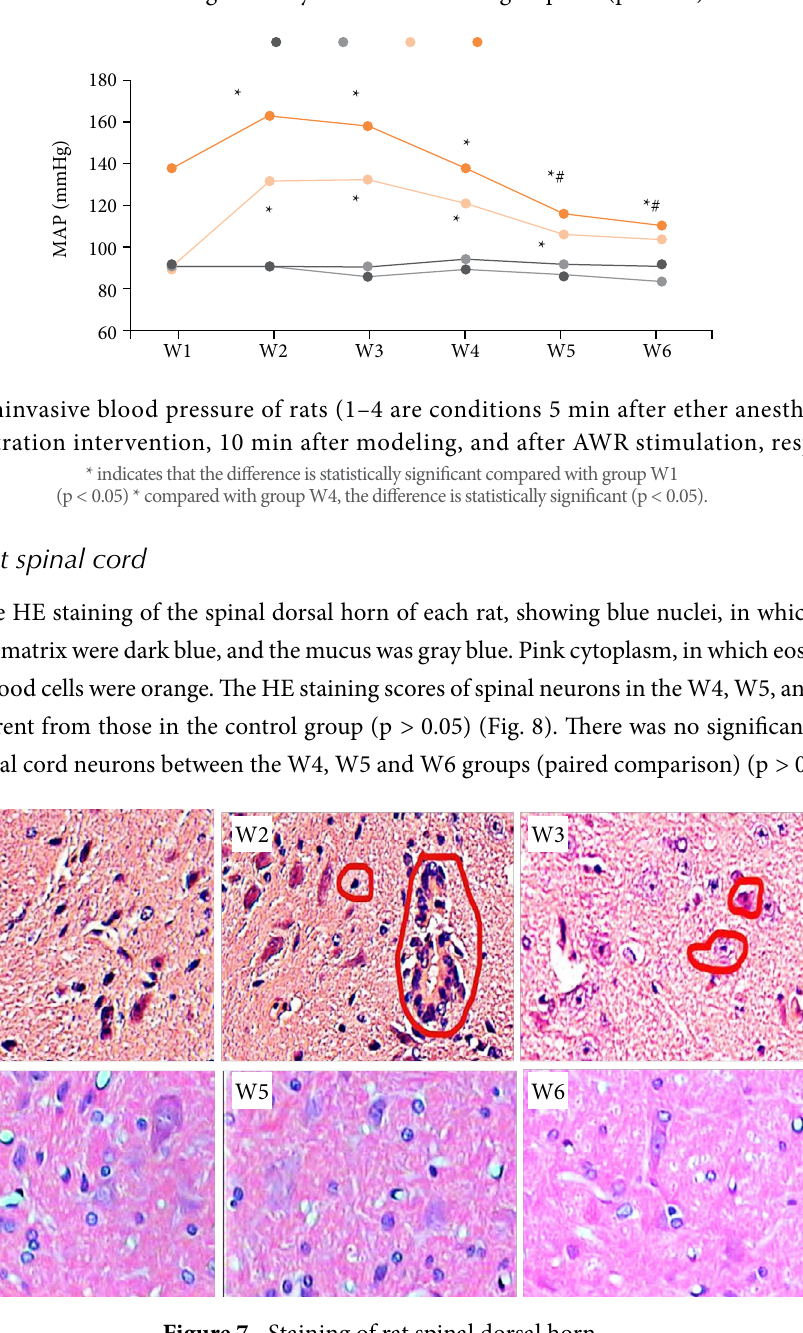
Figure 7 - Staining of rat spinal dorsal